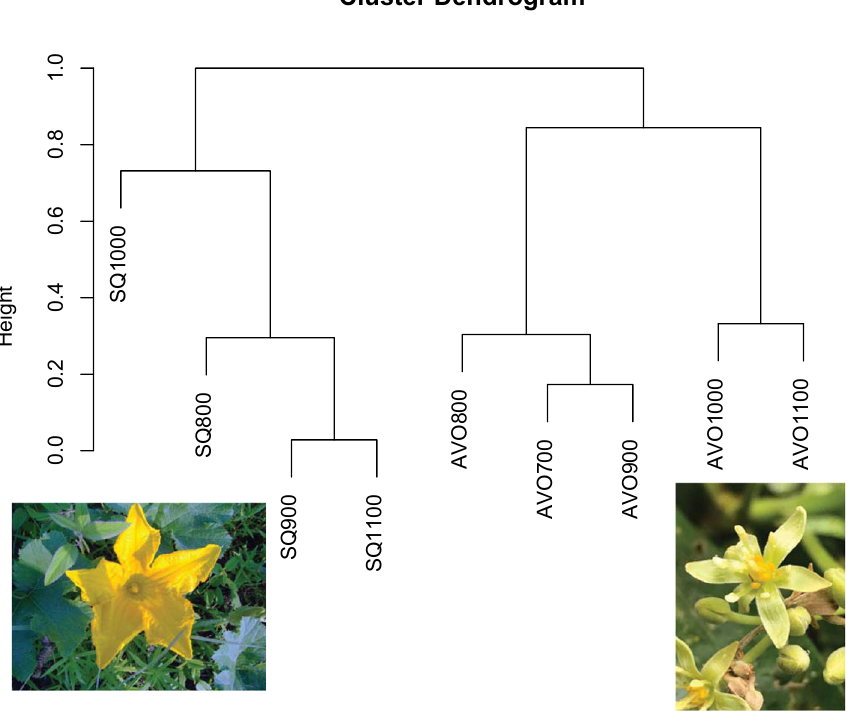
Figure 4. Cluster dendrogram for bee community visiting squash and avocado flowers. Chao dissimilarity index was used to quantify bee community